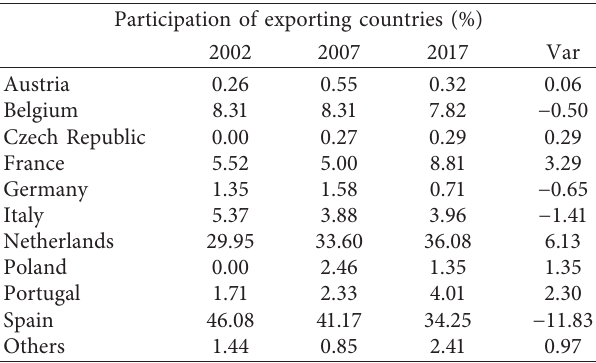
Table 2: Evolution in the participation percentage of exporting countries in the intra-EU tomato market